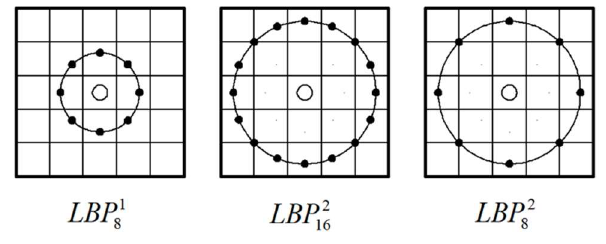
Figure 4. The improved LBP operator.